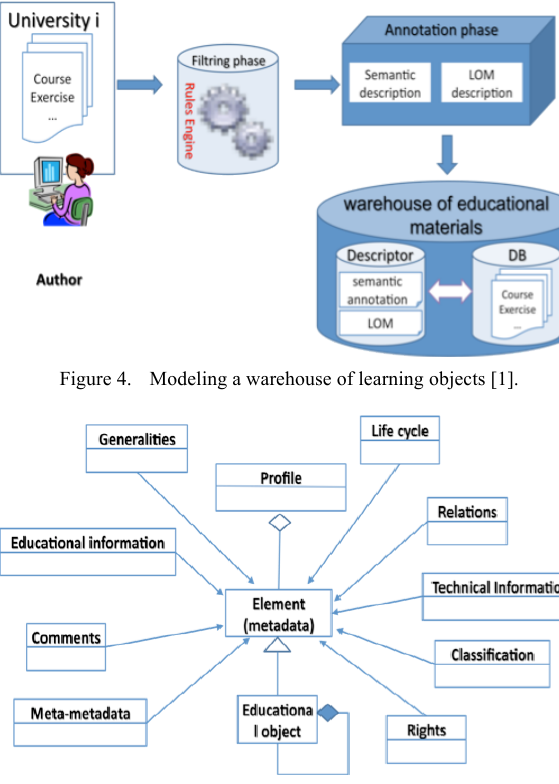
Figure 5. Description of a learning object by LOM